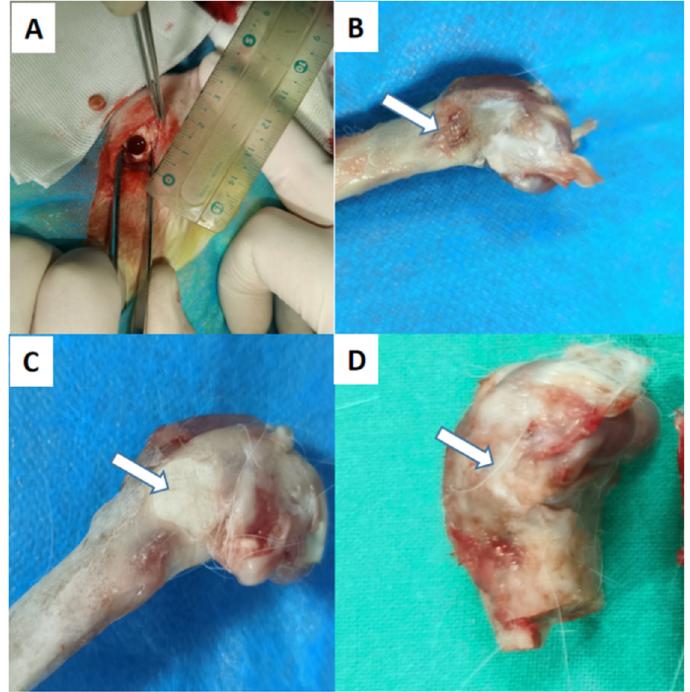
Figure 16. Gross lateral views of the femoral condyle 12 weeks after the operation in three groups of animals: ( A ) bone defect with a diameter of 6 mm drilled through an annulus during the operation; ( B ) blank control group; ( C ) PMMA group; ( D ) 30% PLGA–PEG–PLGA/C 3 S/C 2 S/POP group.